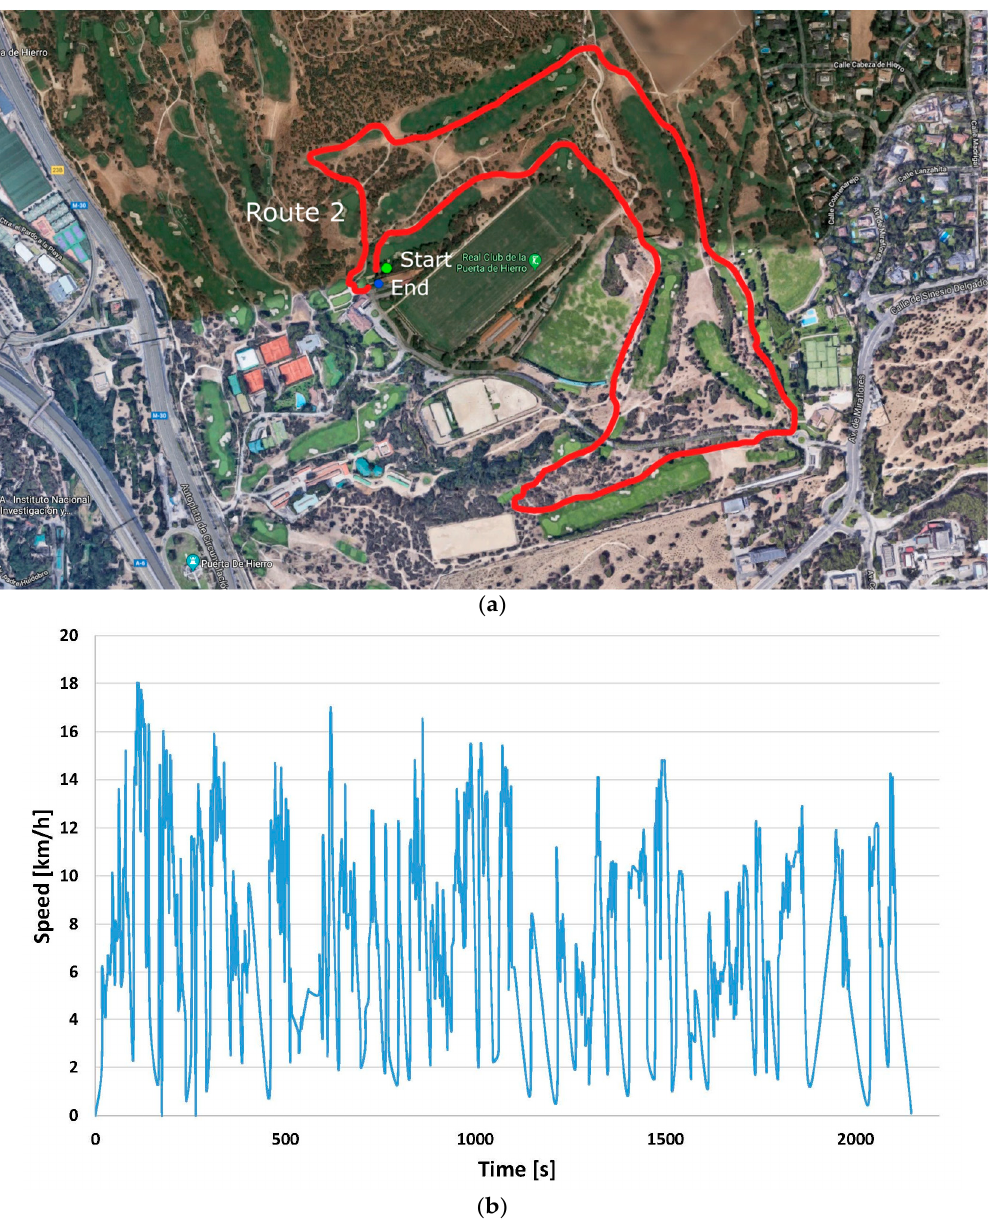
Figure 3. ( a ) Onroad standard testing route; ( b ) Speed profile route 2.